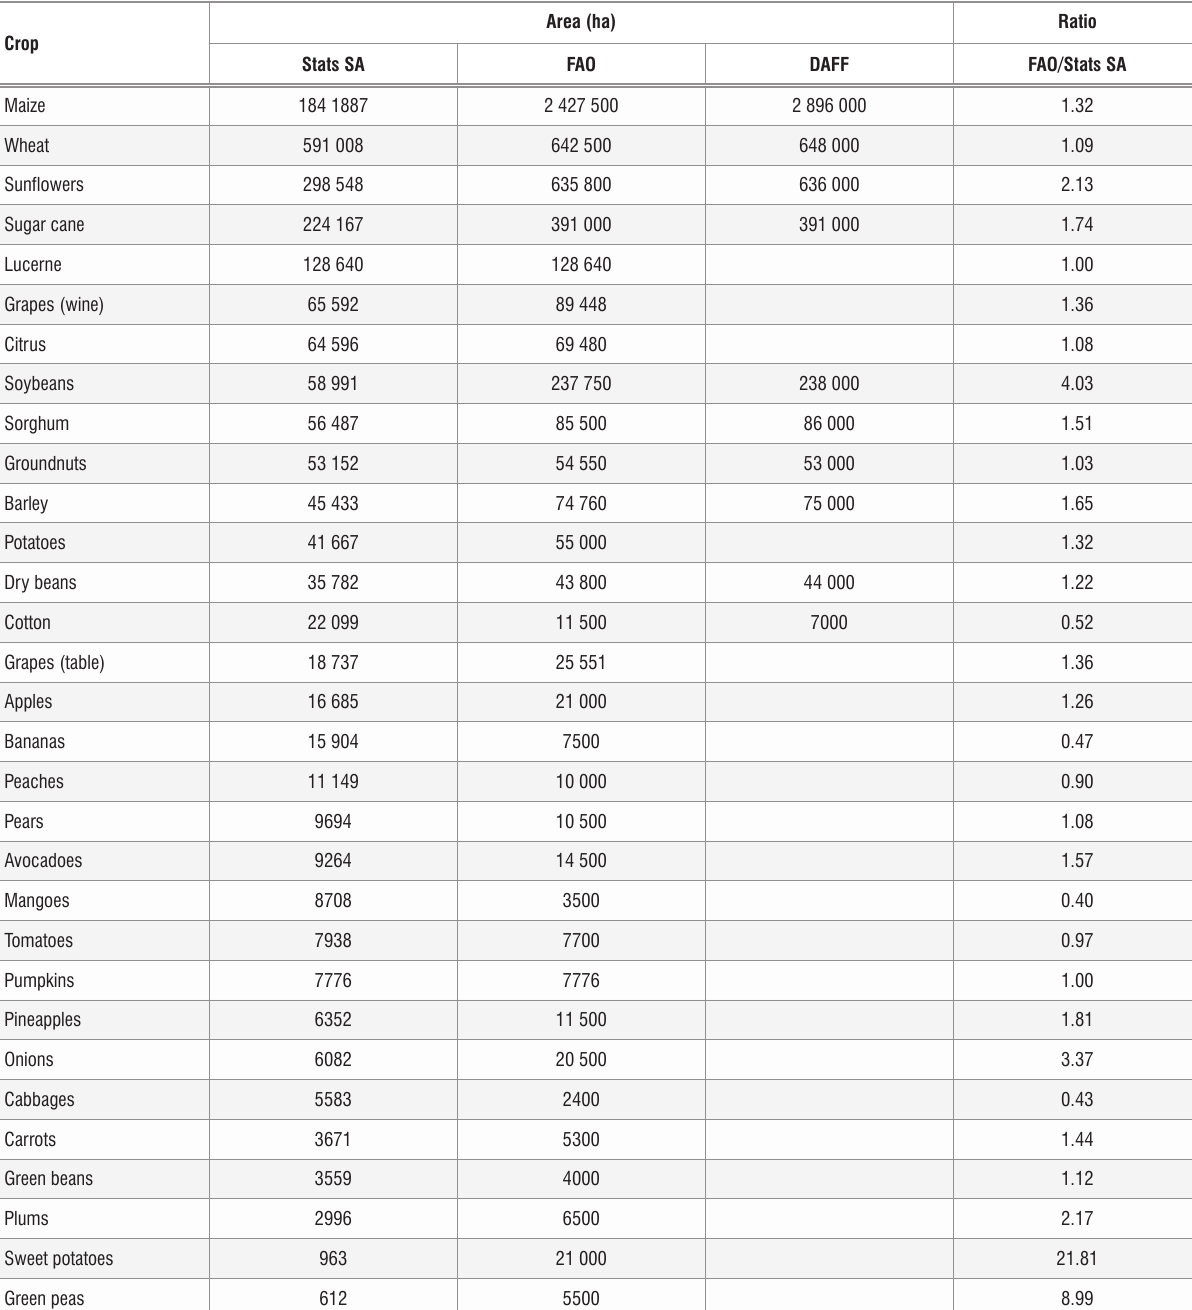
Table 1: National crop area statistics reported by Stats SA 23 , the Food and Agriculture Organization of the United Nations (FAO) 25 and the Department of Agriculture, Forestry and Fisheries (DAFF) 24 for the year 2009. The ratio of FAO to Stats SA statistics was used to normalise crop area data for each magisterial district in South